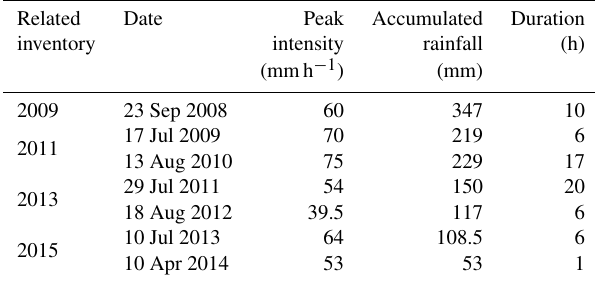
Table 8. Maximum rainfall intensity, duration, and accumulated rainfall of the largest rainfall events of each year. The sources of rainfall data are indicated in Table